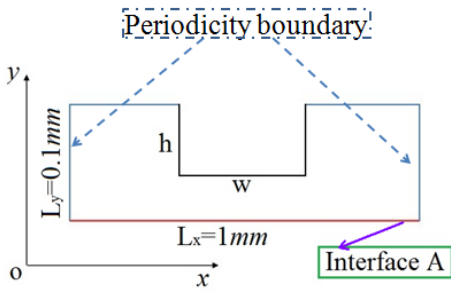
Figure 2. Surface texturing unit model.